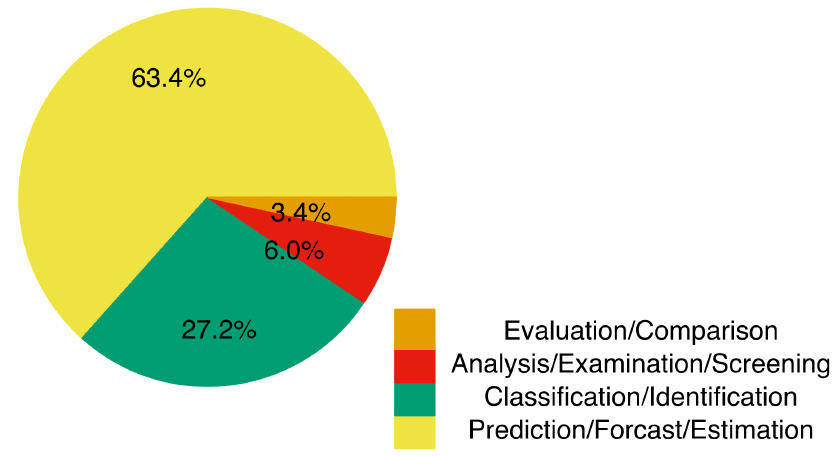
Figure 3. Frequency of Algorithm Goals covered by all